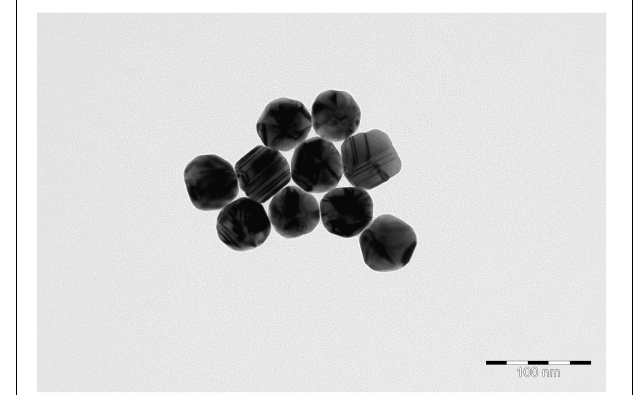
FIGURE 3 | Transmission electron microscopy (TEM) image of